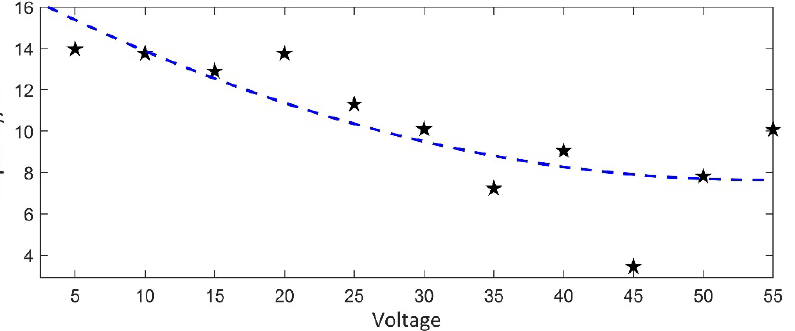
Figure 11. Valley frequency interval under different electrolytic voltages. The pentagrams are the experimentally measured data, and the dashed line is the curve obtained from the polynomial fit.